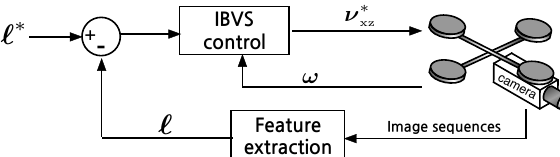
Figure 11. Image-based visual servoing diagram. We model an ordinary camera which has 3 mm focal length, 320 240 image resolution. ν ∗ is the computed desired translational xz × velocity and ω is used for de-rotation in the Imaged-Based Visual Servoing (IBVS) control